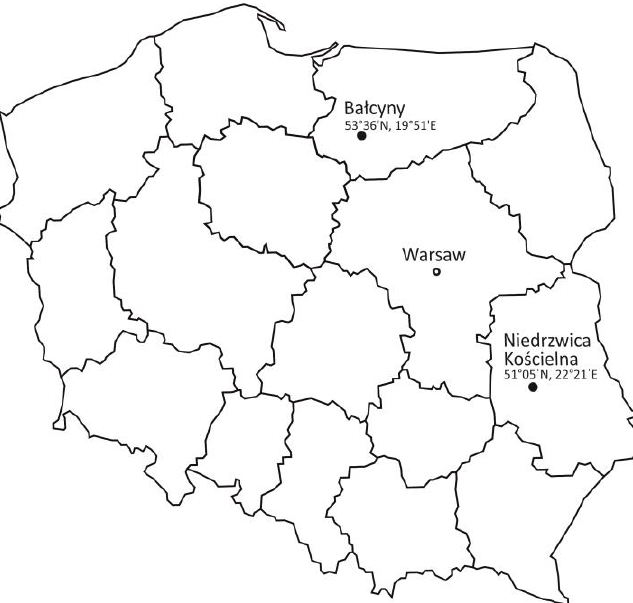
Figure 1. The location of the two localities where the experiments were conducted. Table 1. Weather conditions in vegetation period in 2018.